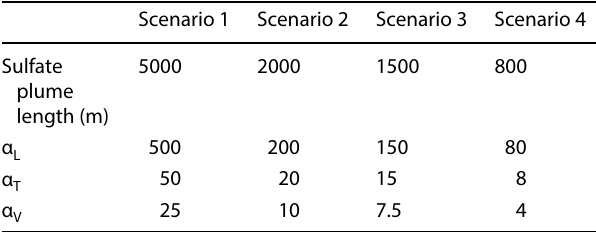
Table 2 Dispersion parameter estimation of four